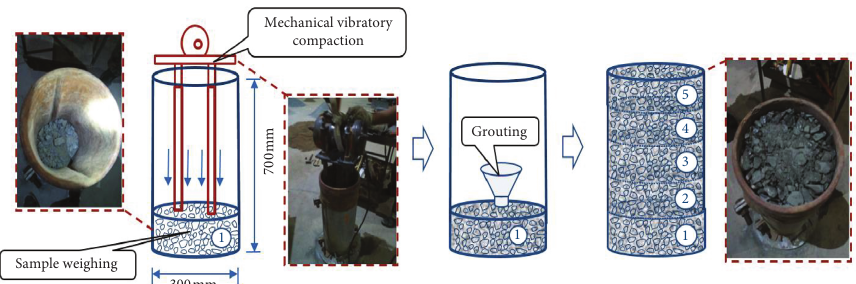
Figure 8: Preparation process of grout-reinforced samples of rockfill materials.